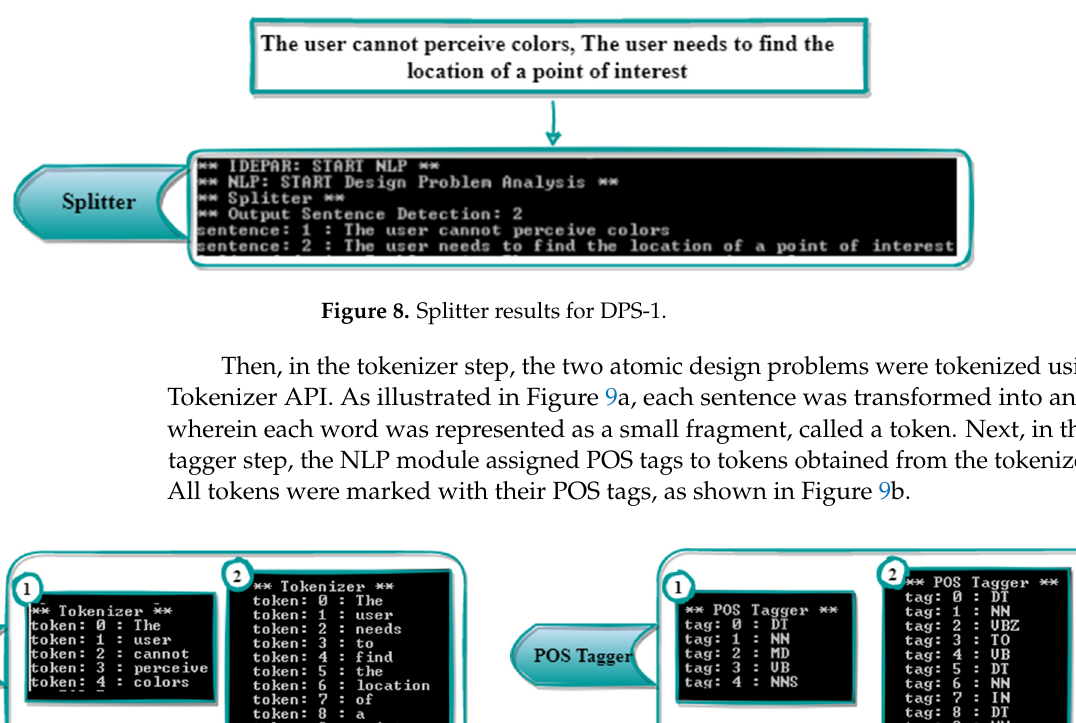
Figure 8. Splitter results for DPS-1.